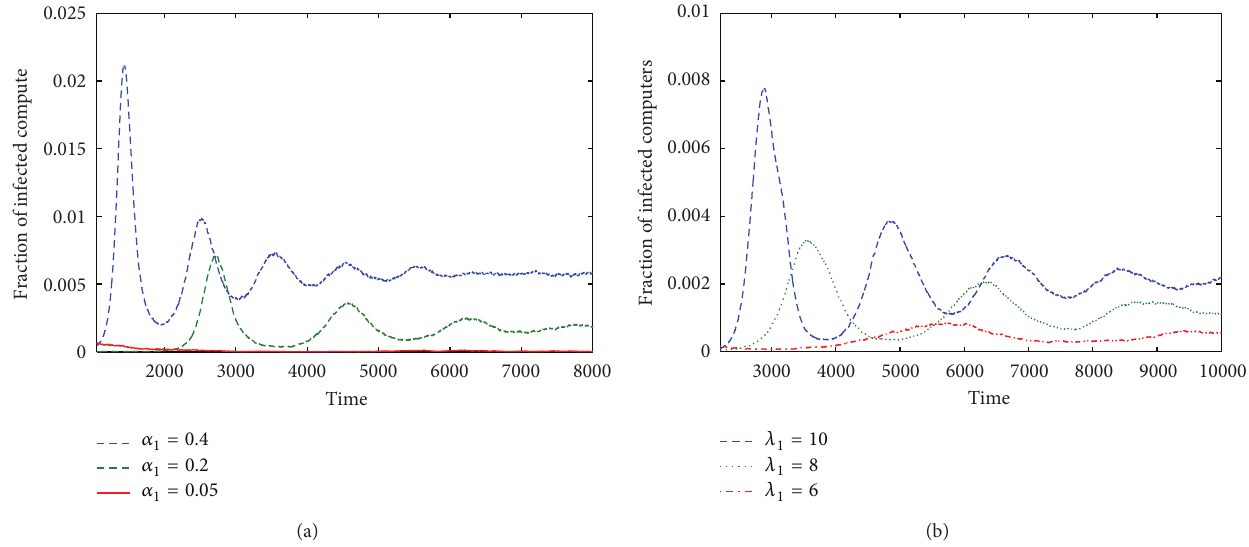
Figure 4: Fraction of infected computers based on model (3) with (a) 𝛼 1 = 0.4 (blue), 0.2 (green), 0.05 (red), and 𝜆 1 = 10 ; (b) 𝜆 1 = 10 (blue), 8 (green), 6 (red), and 𝛼 1 = 0.2 . The other parameters are the same as in Figure